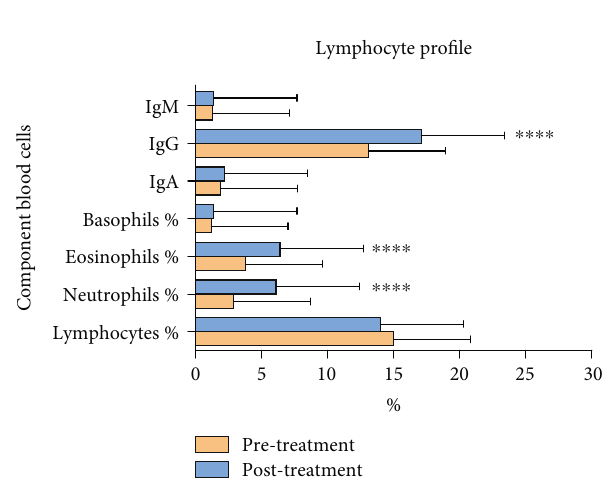
Figure 4: Graphical representation of lymphocyte component blood cells. The % number of IgM, IgG, IgA, basophils, eosinophils, neutrophils, and lymphocytes. There were signi fi cant di ff erences in terms of IgG, eosinophils, and neutrophils between pre- and posttreatment. ∗∗∗∗ p < 0 : 0001 , pre- vs.